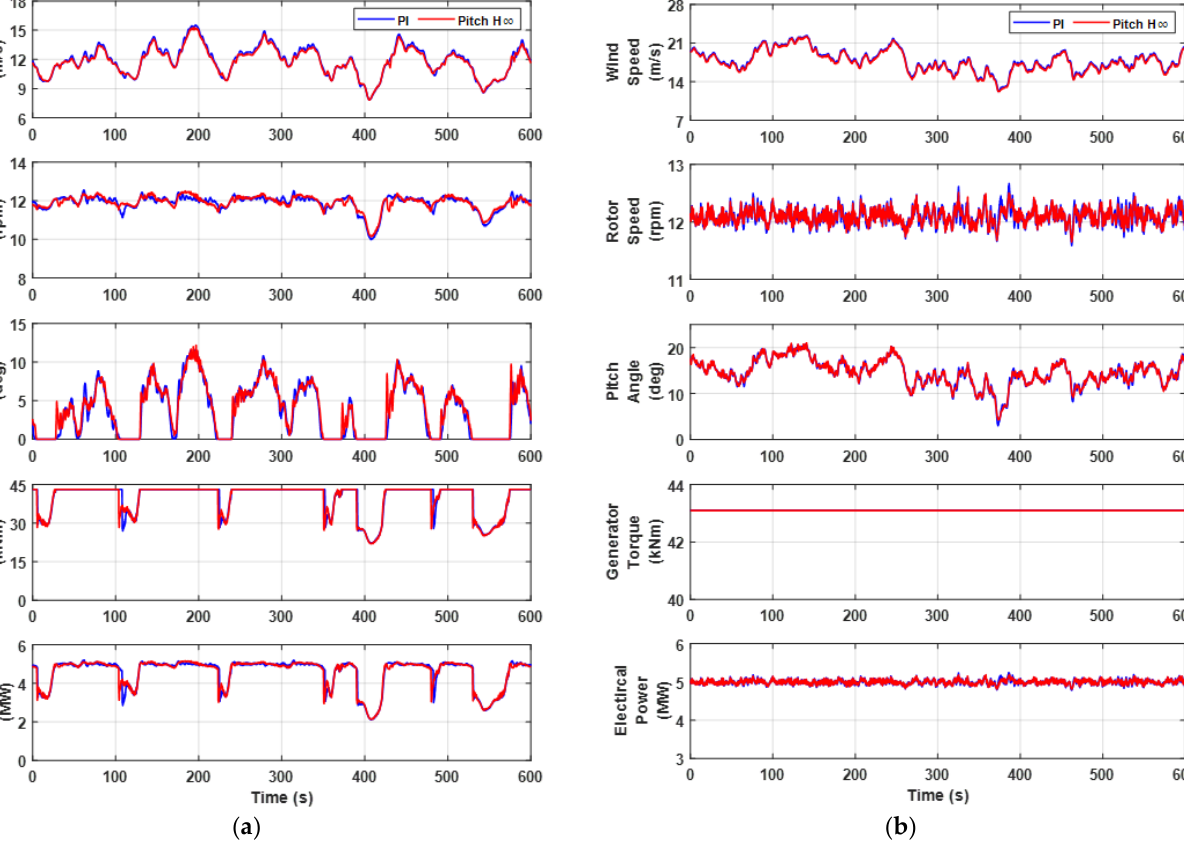
Figure 10. NTM results in noiseless environments. ( a ) Wind speed of 12 m/s; ( b ) wind speed of 18 m/s. Table 2. Comparison of NTM results for performance data in 12 m/s noiseless environment. Mean Std. Dev. Perfor- mance Data